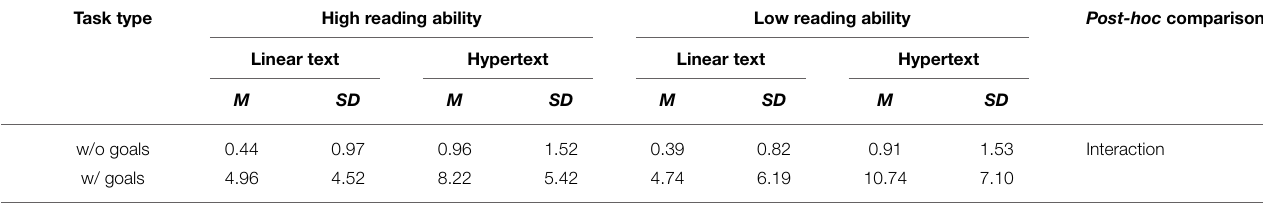
TABLE 4 | Mean and SD values of the RCs of students with different reading abilities reading two types of texts with/without reading goals. Task type